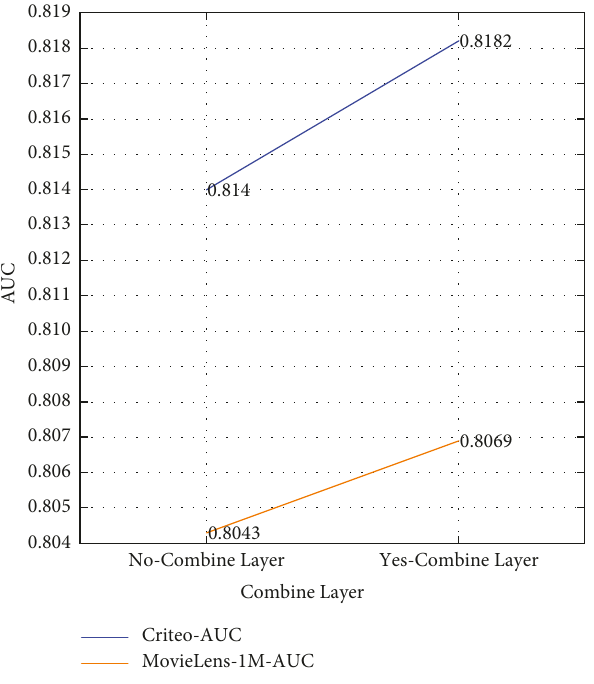
Figure 13: The Combine layer of AUC in model CCPIN.